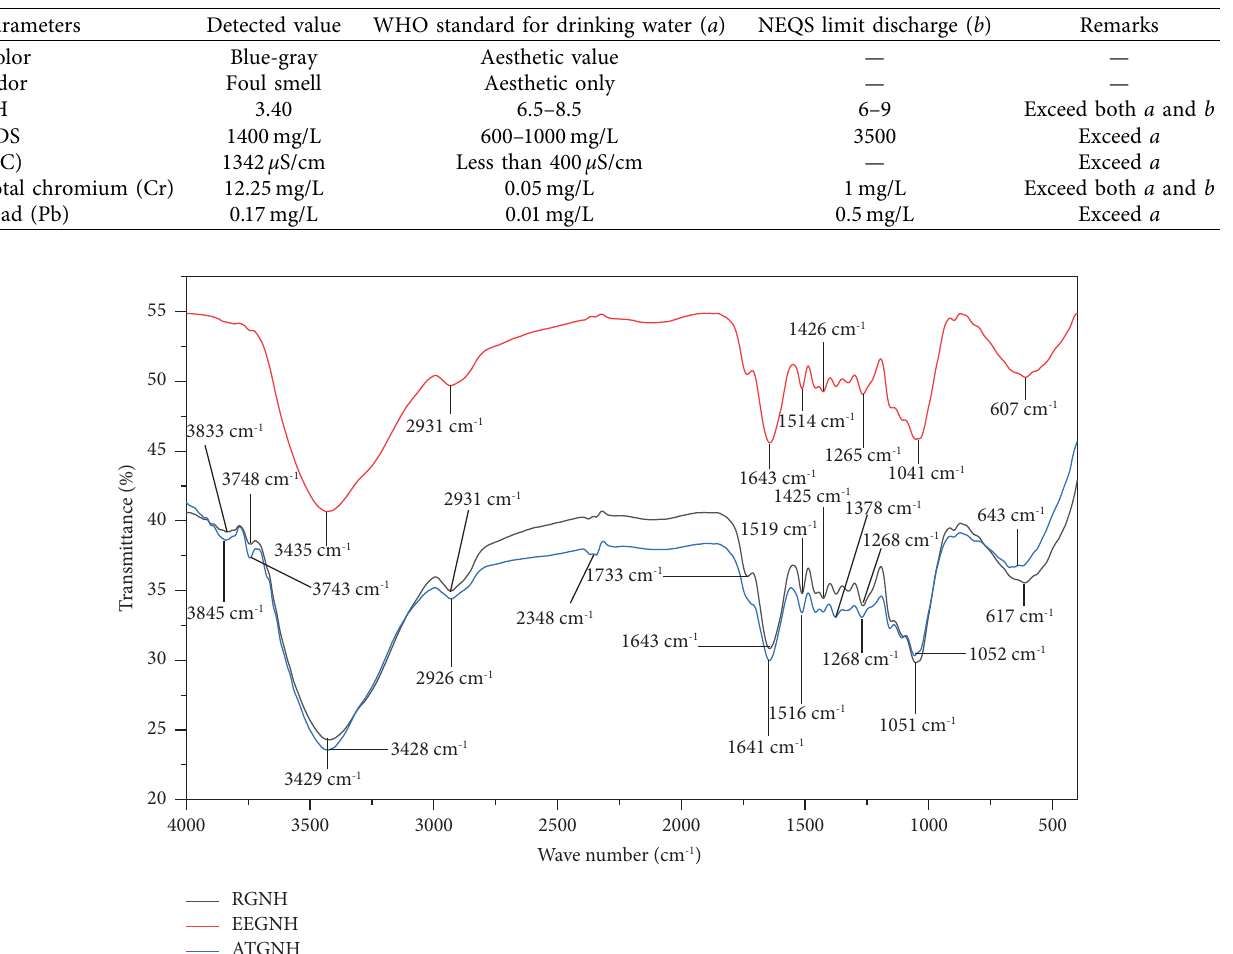
Table 1: Physicochemical characteristics of untreated tannery efuent.